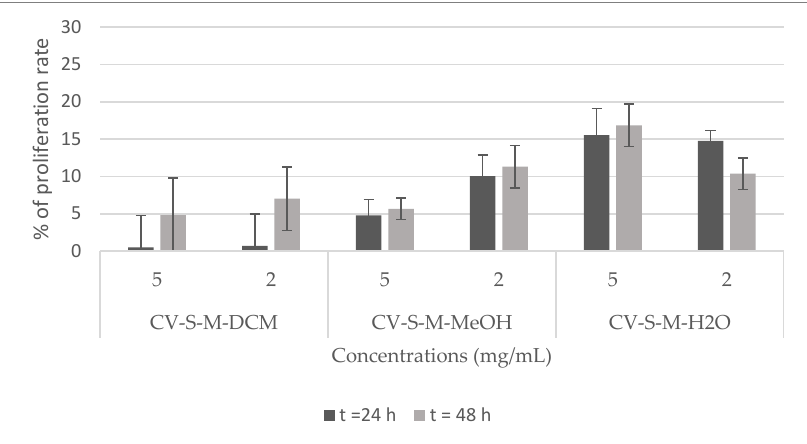
Figure 7. Viability of Hela cells treated with C. villosa stems extracts. All values are expressed as mean of duplicate ± SD.